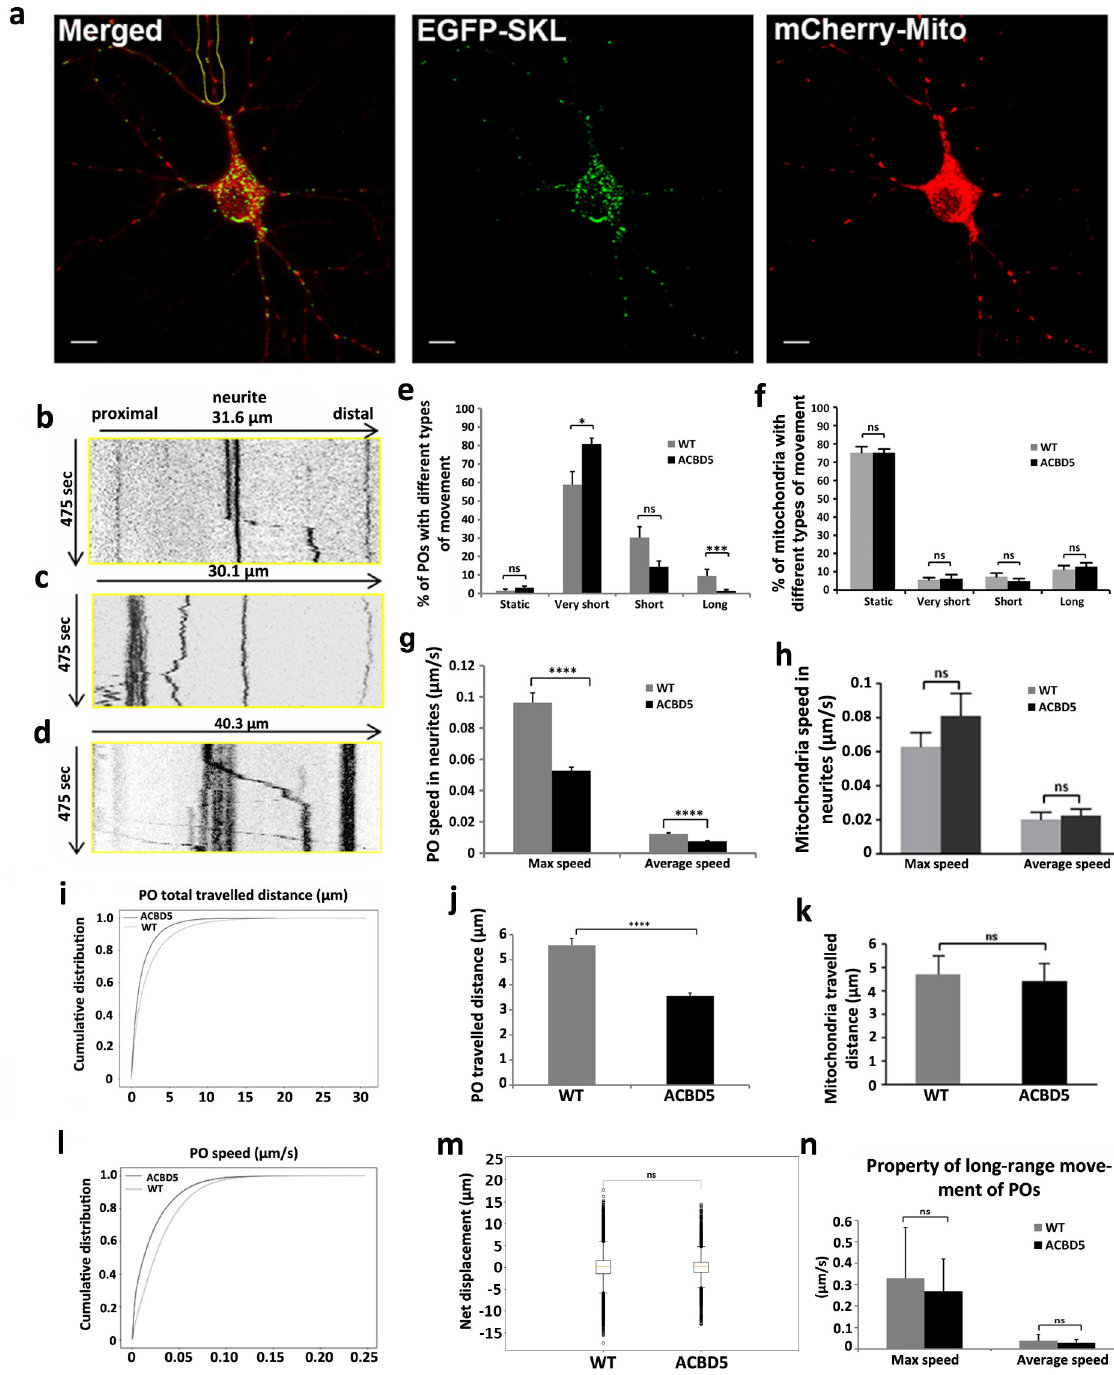
Fig 2. Live confocal imaging analysis of POs and mitochondria in hippocampal neurons. (a) POs and mitochondria were identified by expression of EGFP-SKL and mCherry-mito-7, respectively (Scale bar: 10 μ m). Images are displayed as maximum intensity projections. (b-d) Representative kymographs illustrating peroxisomal (b, c) and mitochondrial (d) movements. Kymograph (b) represents the region of the neurite highlighted in (a). The kymographs were generated from the proximal 30~40 μ m of neurites, straight vertical lines show static POs and mitochondria; Fig 2B includes a rapid saltatory movement across approximately 10 μ m. (e, f) Classification of PO and mitochondria motility into long range movements ( > 10 μ m), short range movements (5 μ m– 10 μ m), very short range movements (1 μ m– 5 μ m), and static organelles ( < 1 μ m) in myc-ACBD5 expressing and control neurons (total analysis time = 8 min). (g, h) Maximum and average speed ( μ m/s) of all measured POs and mitochondria in neurites of ACBD5 expressing and control cells. (j, k) Averaged total travelled distance ( μ m)